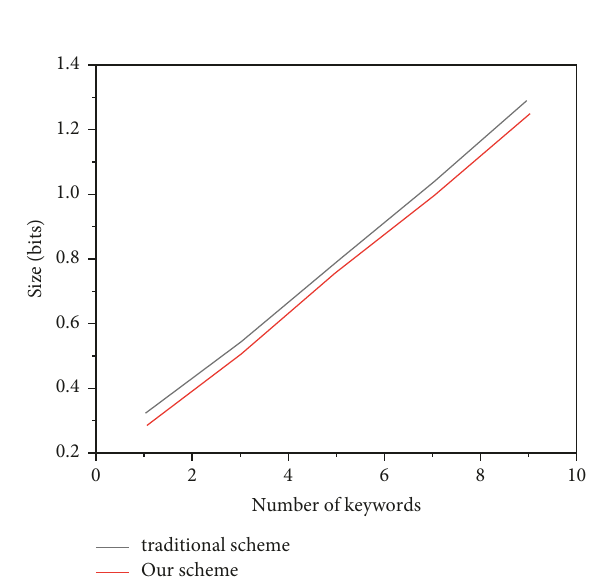
Figure 11: Length of